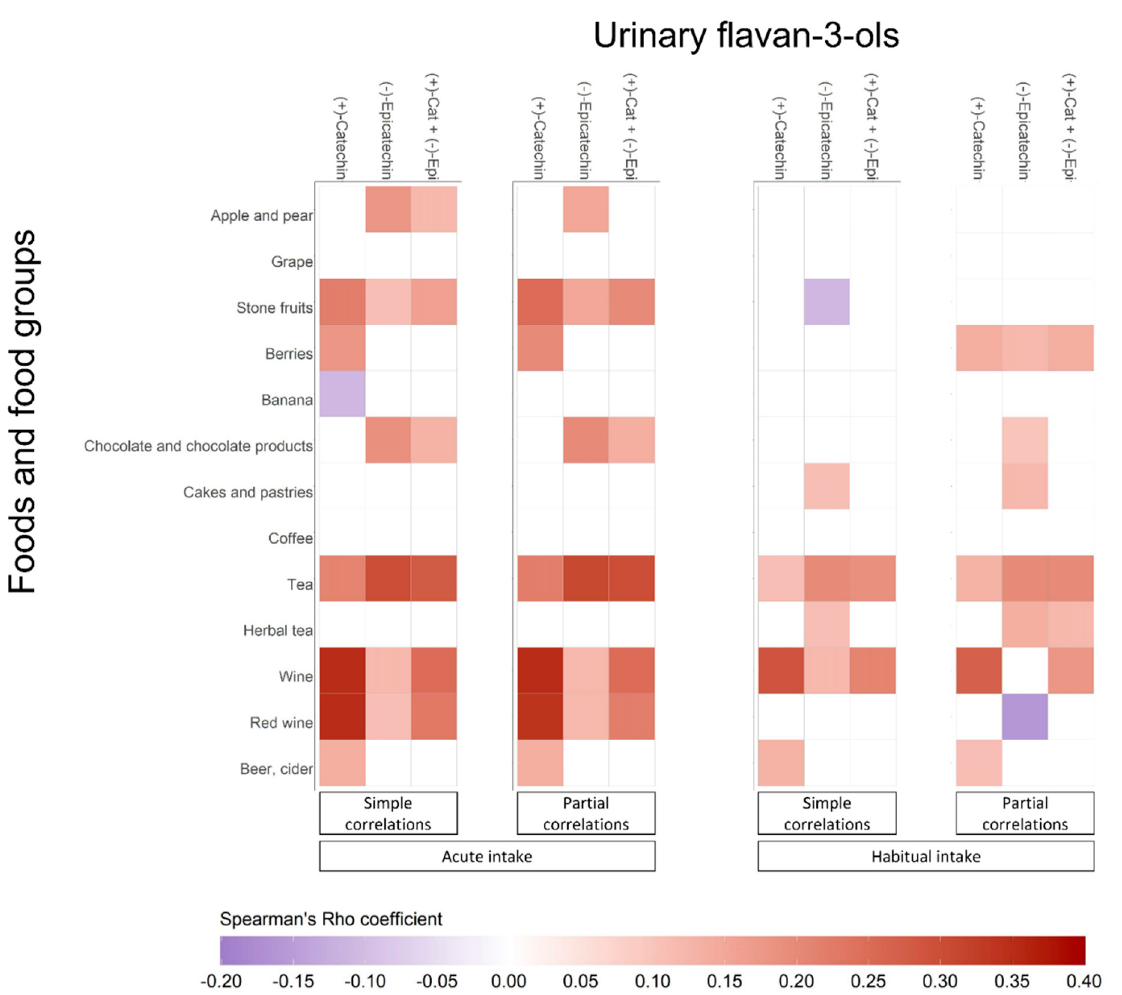
Figure 2. Heatmaps showing simple and partial Spearman’s correlations between urinary flavan-3-ols and intake (acute and habitual) of foods. Abbreviations: 24-HDR, 24-h dietary recall; (+)-Cat, (+)-catechin; DQ, dietary questionnaire; (-)-Epi, (-)-epicatechin.